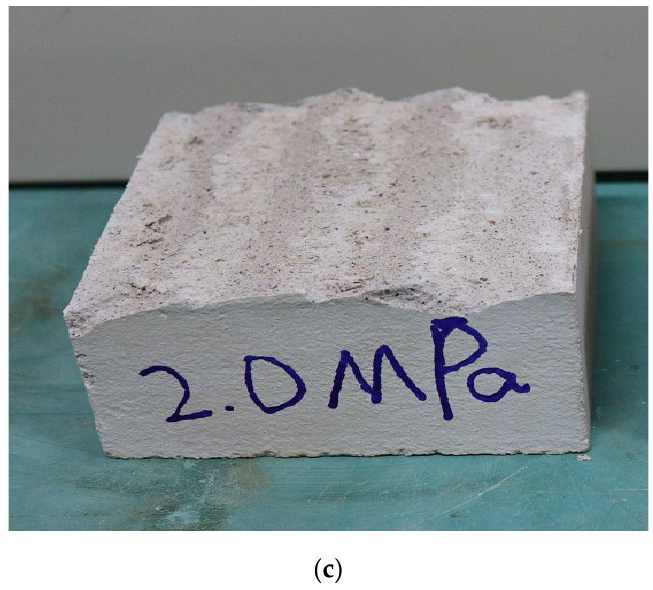
Figure 9. Saw-toothed sliding gnawing failure mechanism of joints. ( a ) Slip failure at 10° sawtooth angle under 0.4 MPa normal stress; ( b ) Slip gnawing failure at 20° sawtooth angle under 1.2 MPa normal stress; ( c ) Complete gnawing failure at 45° sawtooth angle under 2.0 MPa normal stress.